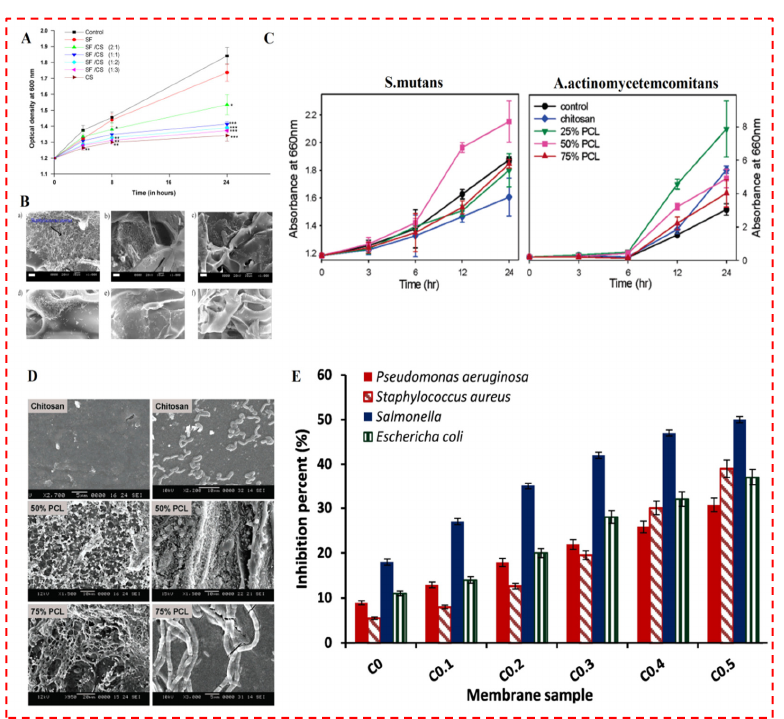
Figure 8. ( A ) Effect of matrix structures and composition on antibacterial activity of SF/CS scaffolds. ( B ) Scanning electron microscopy (SEM) demonstrates attachment of S. aureus on neat and blended scaffolds. Neat silk fibroin (SF) scaffolds ( a ), SF/CS (2:1) ( b ), SF/CS (1:1) ( c ), SF/CS (1:2) ( d ), SF/CS (1:3) ( e ), and neat CS scaffolds ( f ). Note: Scale bar = 10 µm [107]. ( C , D ) Influence of blending on antibacterial behavior of CS. Chitosan (CS), poly caprolactone (PCL), and blend membranes were soaked in bacterial broths of S. mutans and A. actinomycetemcomitans and incubated aerobically at 37 °C [108]. ( E ) Antibacterial activity of crosslinked gelatin/CS membranes, with various concentrations of cinnamaldehyde, towards P. aeruginosa , S. aureus , Salmonella , and E. coli . Values